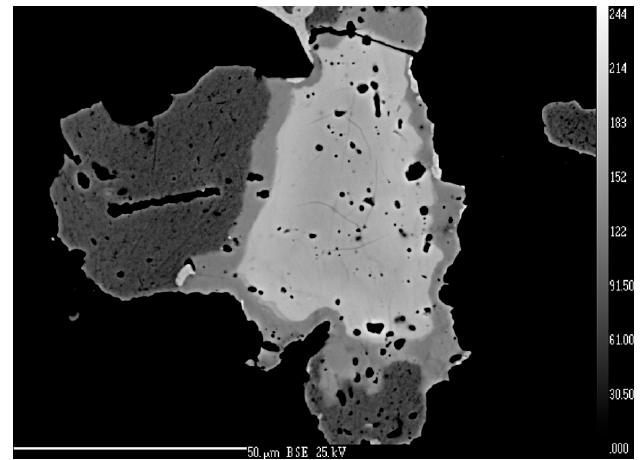
Figure 51. The core of aggregate formed by hakite (light grey) is rimmed by giraudite (grey); berzelianite (dark grey) is the youngest mineral in the association. BSE photo. P ř íbram, a dump of shaft 16. Photo by J. Sejkora and P. Škácha.